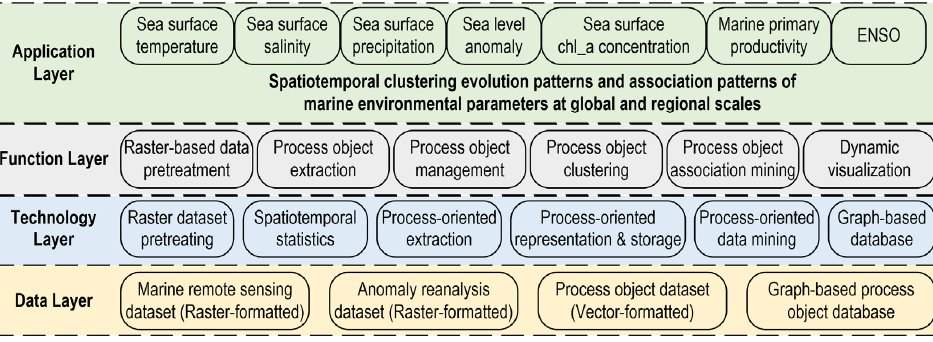
Figure 1. System